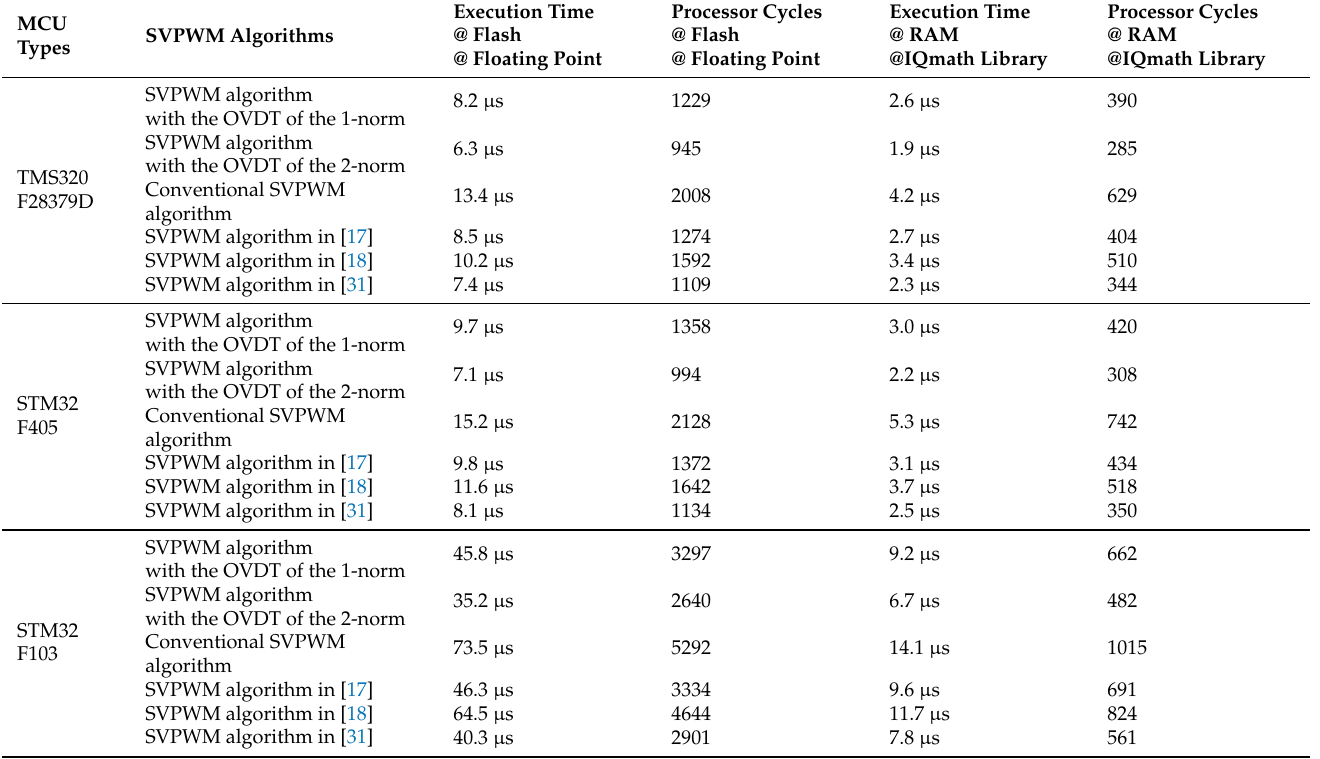
Table 3. Execution time of the SVPWM